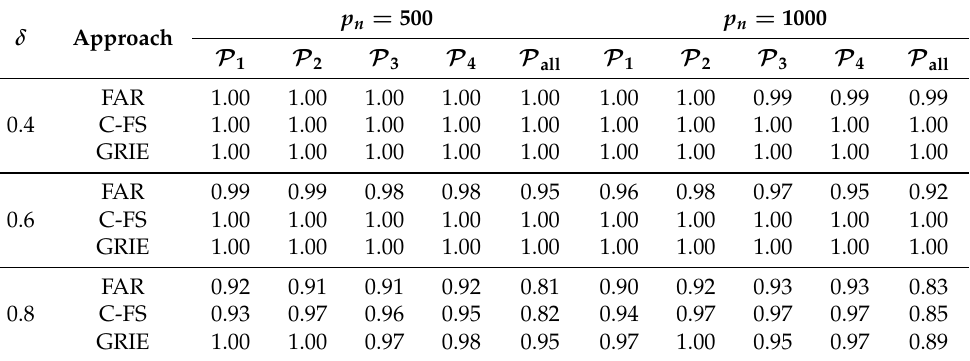
Table 6. The empirical probabilities of each important covariate and all important covariates being retained for 100 replications in Example 2 with (cid:101) ∼ N ( 0,1 )